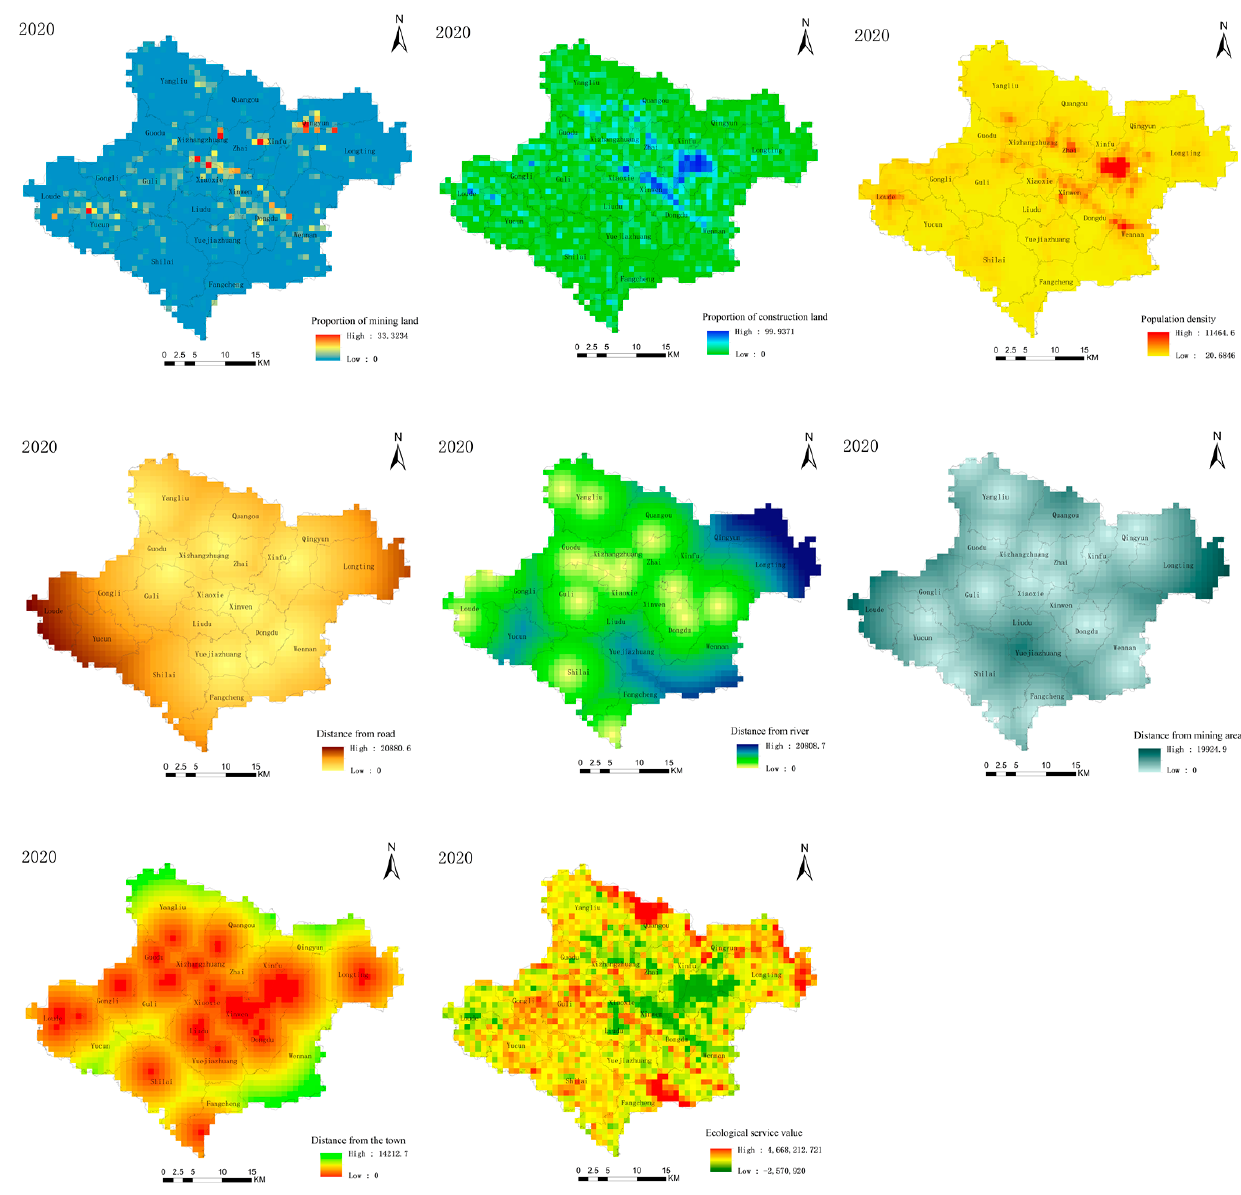
Figure 3. Spatial patterns of the spatial conflict measurement indicators in Xintai (2020).